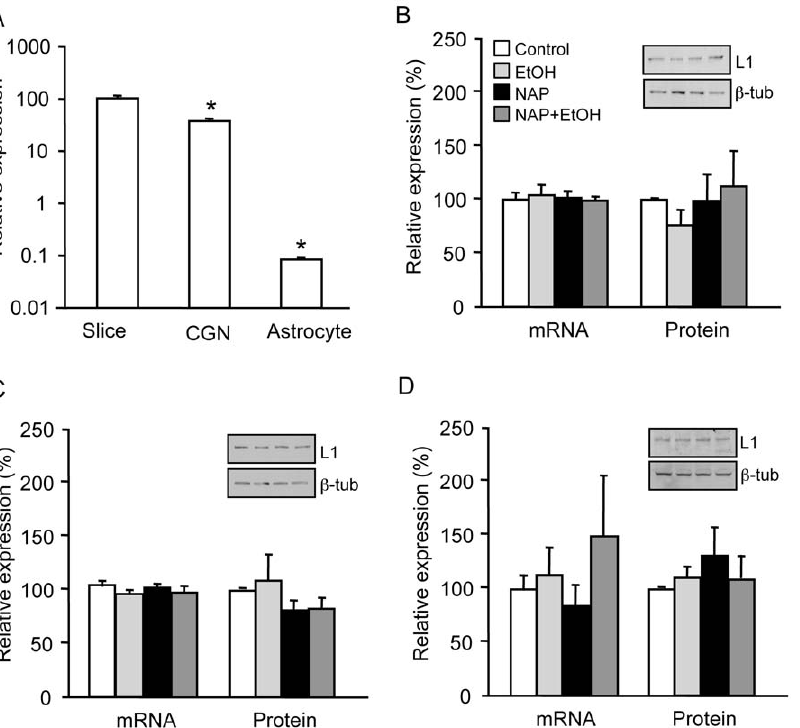
Figure 2. L1 expression in cerebellar slices, CGNs, and astrocytes. A) Comparison of L1 transcript levels in different culture preparations. * p , 0.0001 compared to slices. B–D) Total RNA and cell lysates were collected from slice, CGN, and astrocyte cultures after 24-hr exposure to 20 mM ethanol, 10 2 12 M NAP, or the combination of NAP and ethanol. L1 mRNA expression was measured by qRT-PCR and normalized to 18S. L1 protein levels were measured by Western blot and normalized to b -tubulin (representative images shown above corresponding bars). L1 mRNA and protein levels are shown in cerebellar slices (B), CGNs (C), and astrocytes (D). Legend in B applies to B–D. All bars represent normalized mean + SEM of 4 independent experiments.